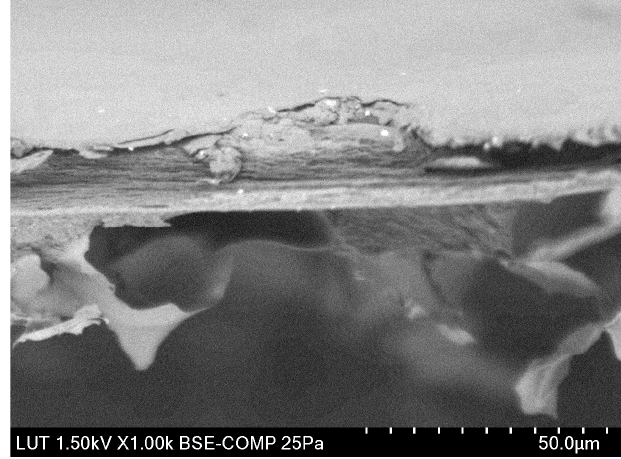
Figure 5. SEM image of 0.4 wt.% LiCl membrane’s cross-section taken via scanning electron micro- scope (Hitachi SU 3500, Japan) at an acceleration voltage of 1.5 kV in high vacuum conditions.